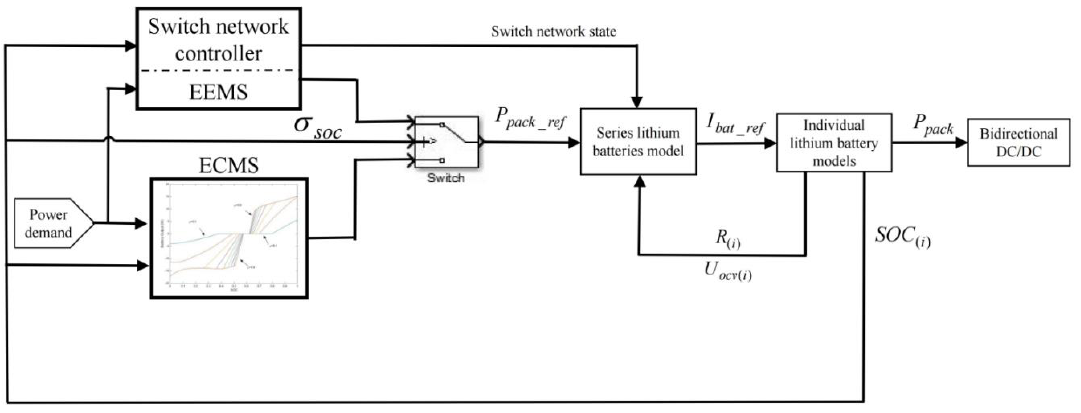
Figure 6. The block diagram of the switched energy management strategy.